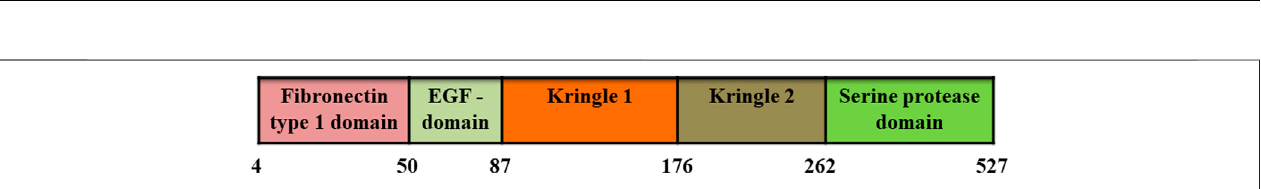
FIGURE5| Domain structure ofrecombinanttissue-type plasminogenactivator (rtPA). Itconsistsof fi bronectintypeIdomain,anepidermal growth factor domain, as well as kringle 1, kringle 2 and serine protease domains.